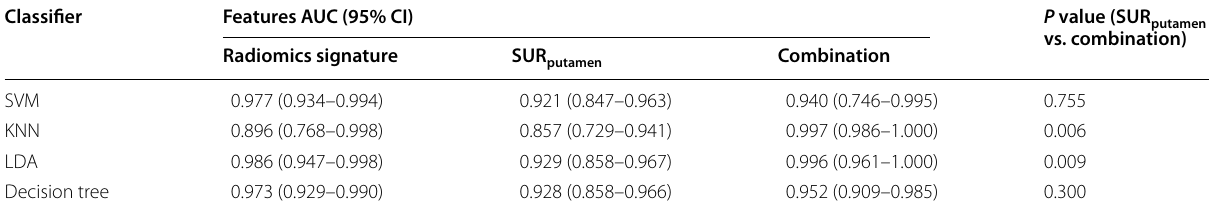
for test dataset 2 putamen